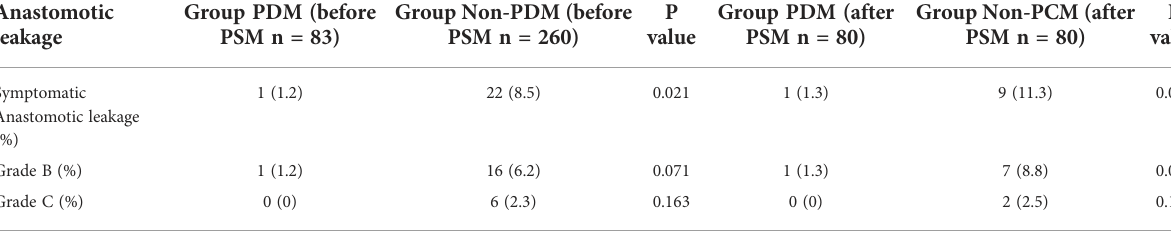
TABLE 3 Postoperative Anastomotic